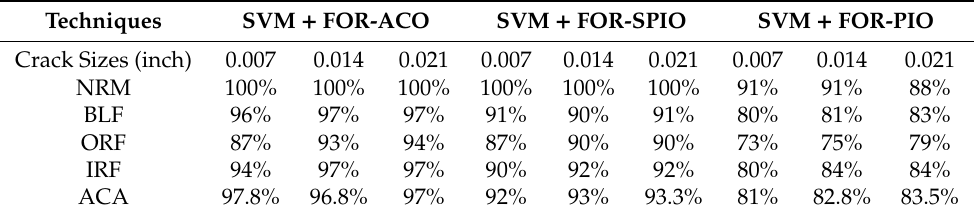
Table 9. The Accuracy of Single-Type Fault Identification to Test the Load-Variant Dataset. Techniques SVM + FOR-ACO SVM +